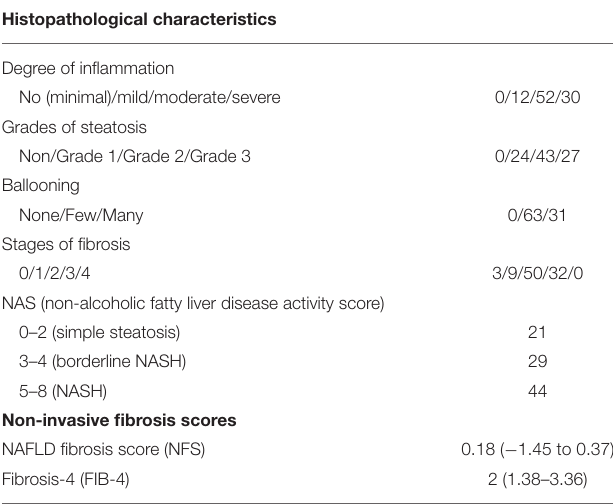
TABLE 2 | Histopathological characteristics and fibrosis scores of enrolled patients at the baseline of the study. Histopathological